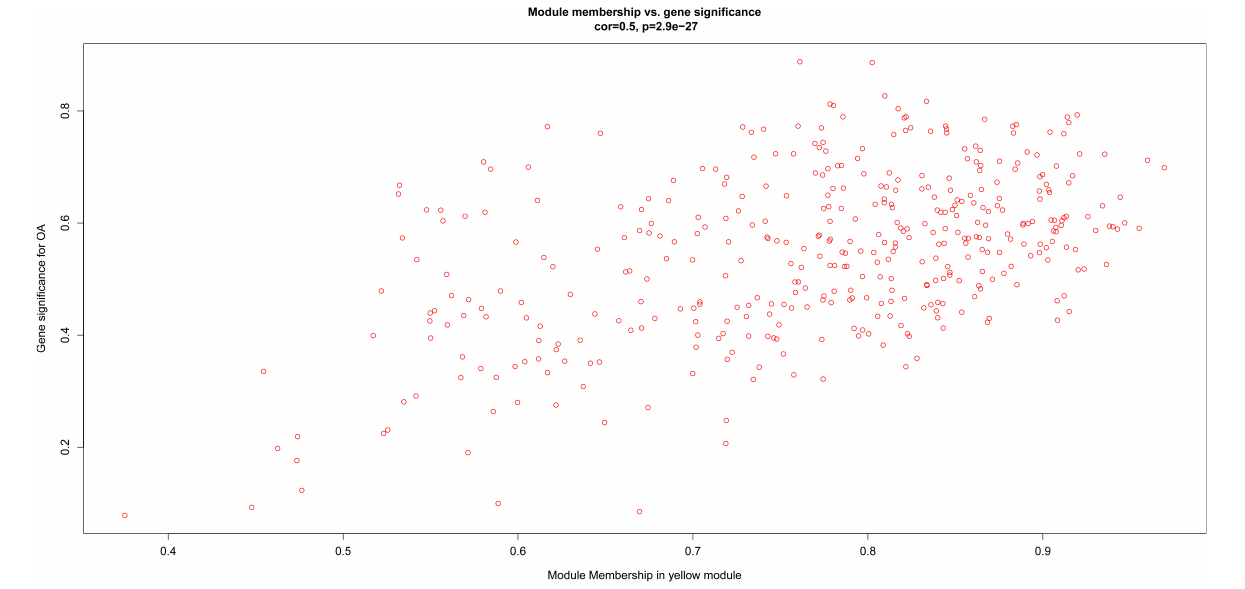
FIGURE 5 | Scatter diagram for module membership vs. gene significance of stage (OA or non-OA) in yellow module.